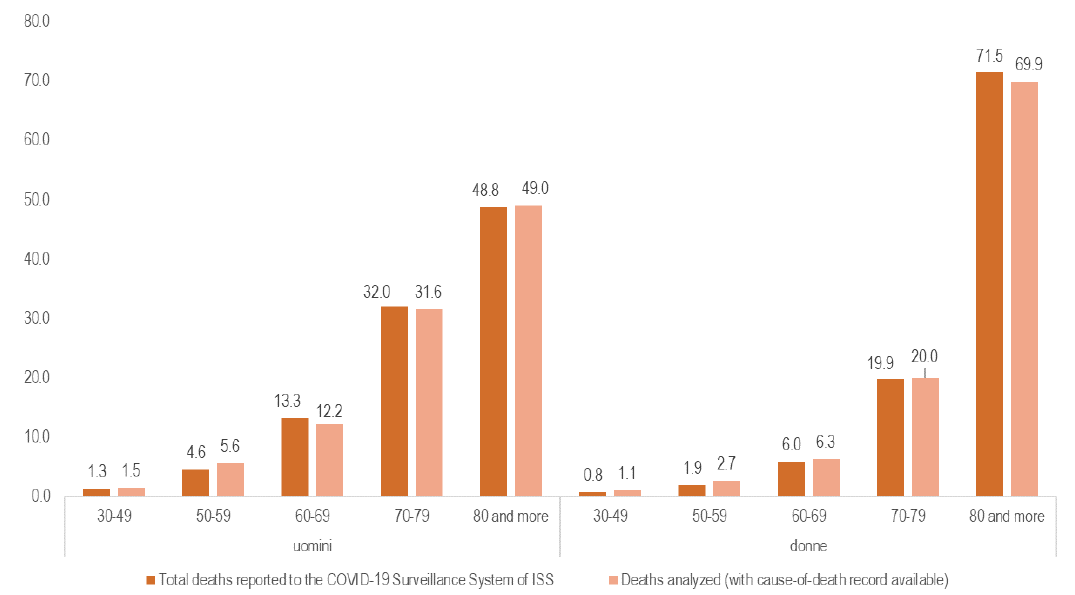
Figure A1. Age and gender distribution of all deaths occurring in SARS-CoV-2–positive patients on 28 May 2020 ( n = 31,851) and in the study sample ( n = 5311).